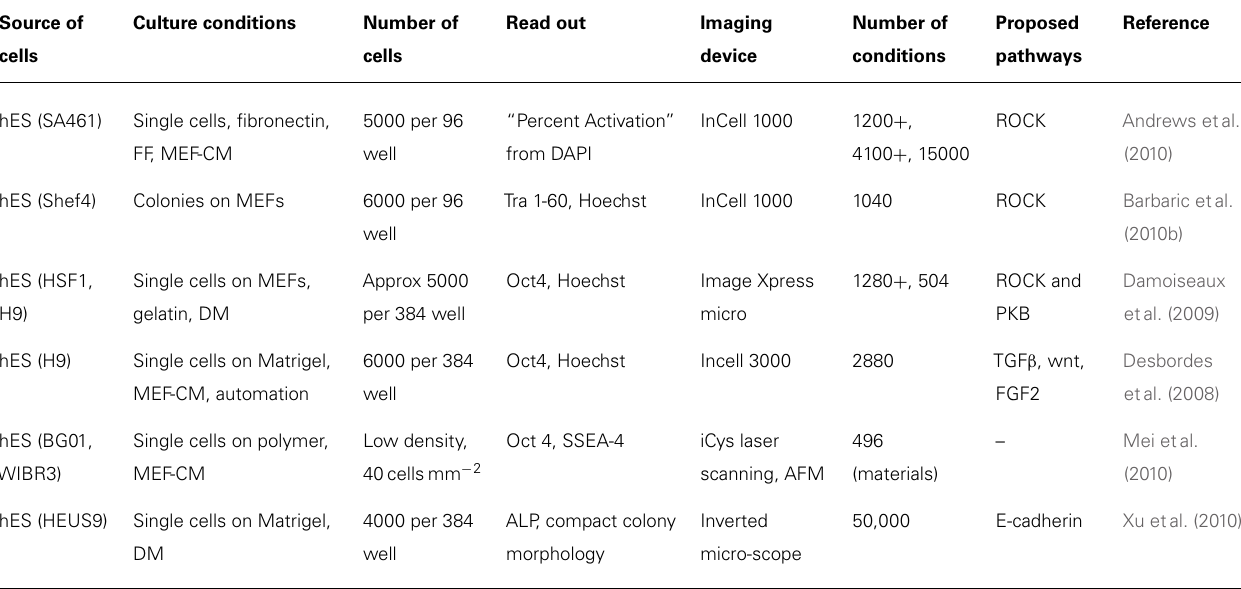
Table 1 | High content analysis chemical screens using human pluripotent stem